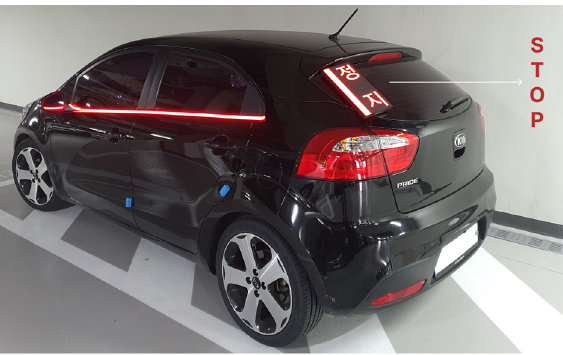
Figure 3. eHMI implemented on a real car used for recording (physical prototype).